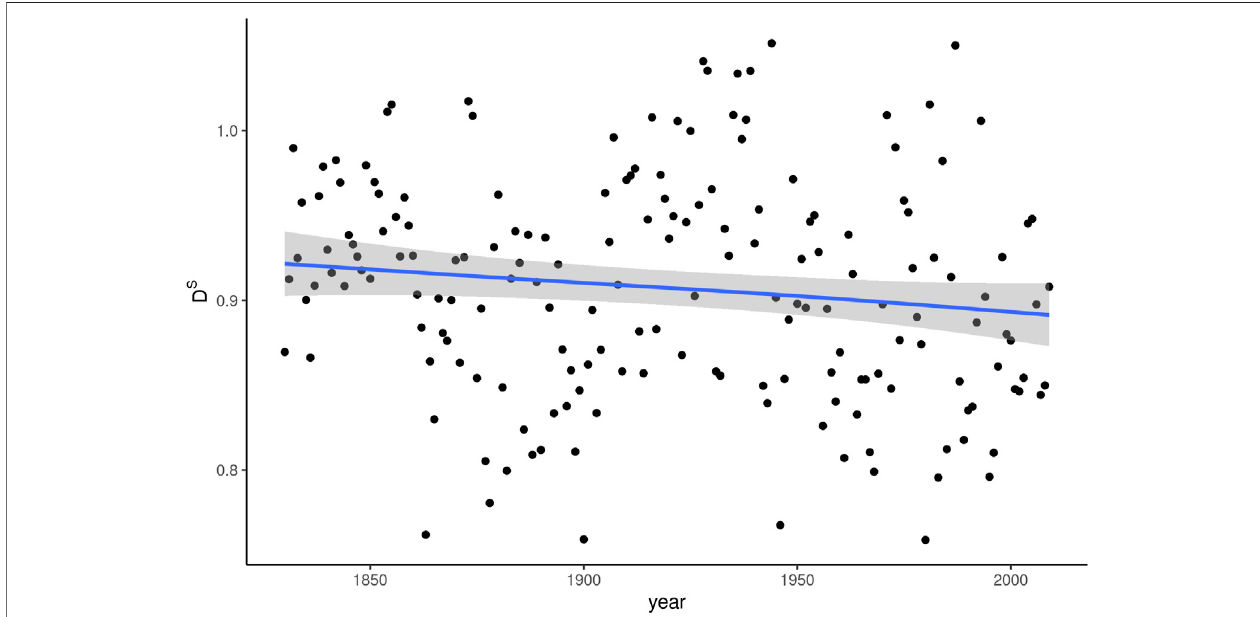
FIGURE 2 | Social dissemination (D S ) of whom over 180 years of written American